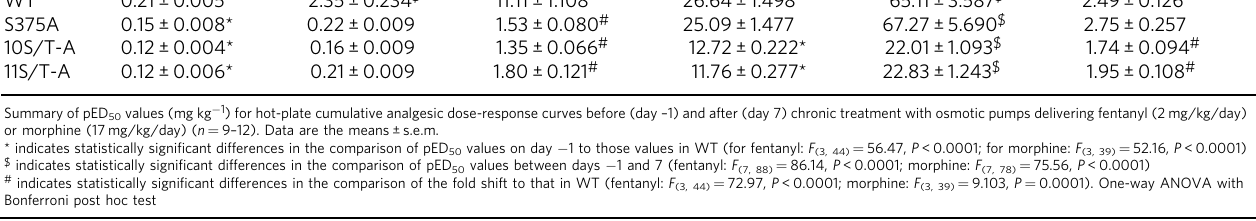
Table 1 Analgesic potency before and after chronic treatment Fentanyl (mg kg -1 ) Morphine (mg kg -1 ) Day − 1 Day 7 Fold shift Day − 1 Day 7 Fold shift WT